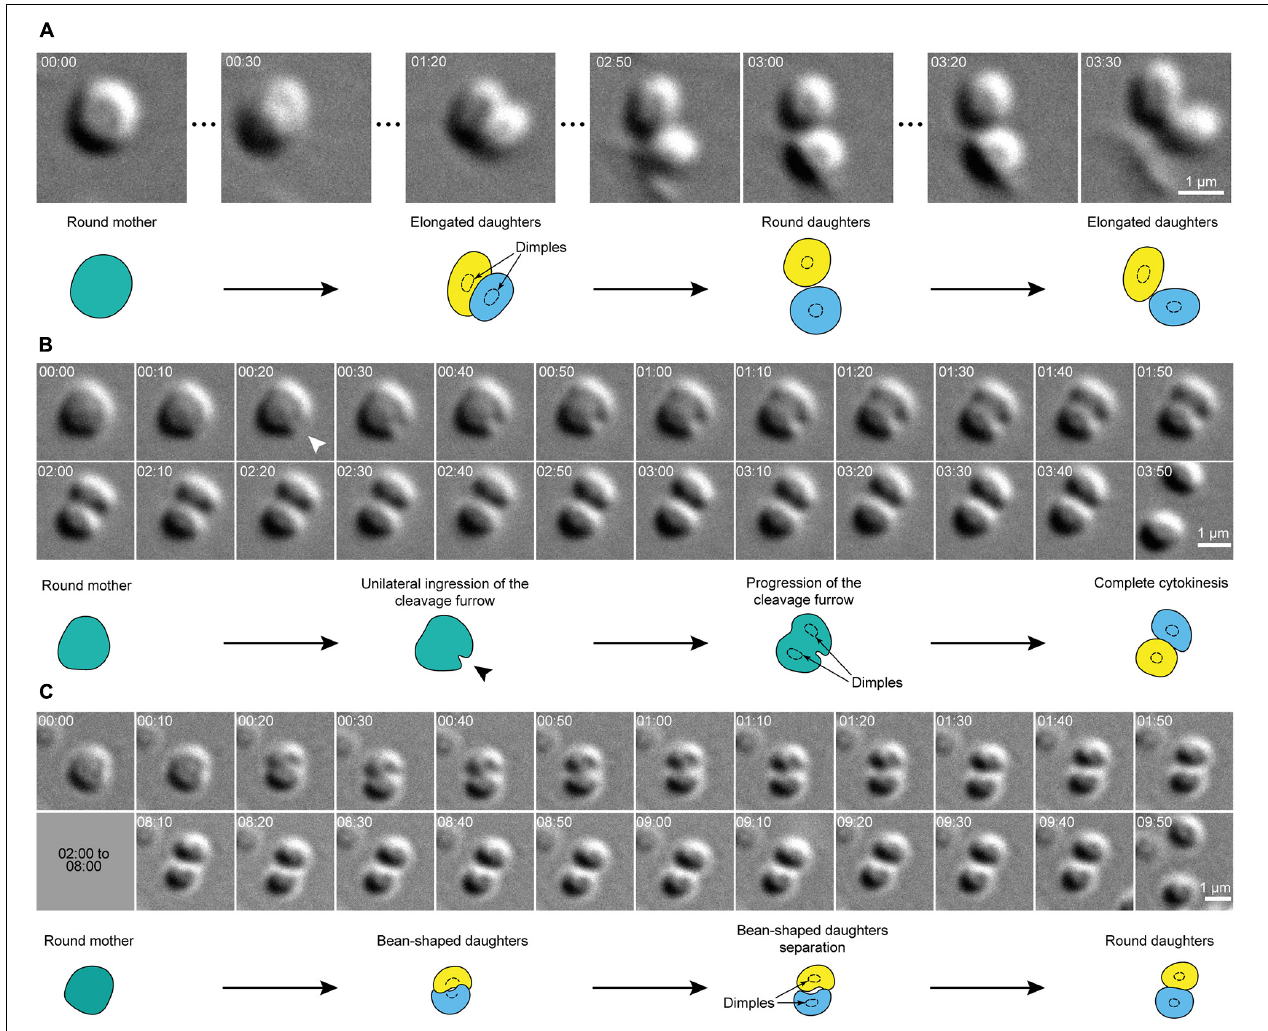
FIGURE 2 | Cell shape transitions during cytokinesis in S. acidocaldarius . (A) Snapshots of a dividing cell. The round mother cell divides into two daughter cells that rapidly oscillate between an oval shape and a round shape. (B) Evidence for the unilateral ingression of the cleavage furrow in a dividing cell. Arrowheads point to site of ingression of the cleavage furrow. (B,C) Examples of round mother cells splitting into two bean-shaped daughters that revert to a round shape upon full division. In both cases, daughter cells eventually part. DIC, 75 ◦ C, 100X + 1.5X lens. Times are provided in min:sec. Interpretative diagrams are shown below each series of snapshots, with cell dimples shown as dotted